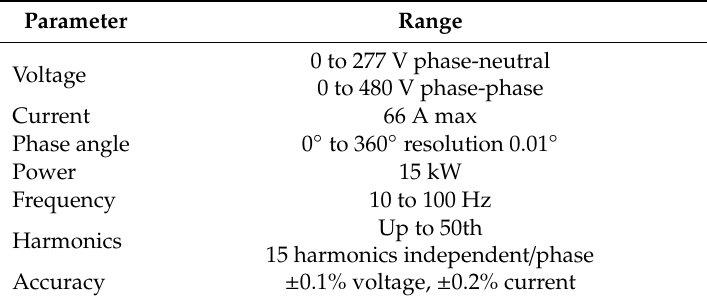
Table 2. Main features of grid emulator, model Cinergia GE + 15.